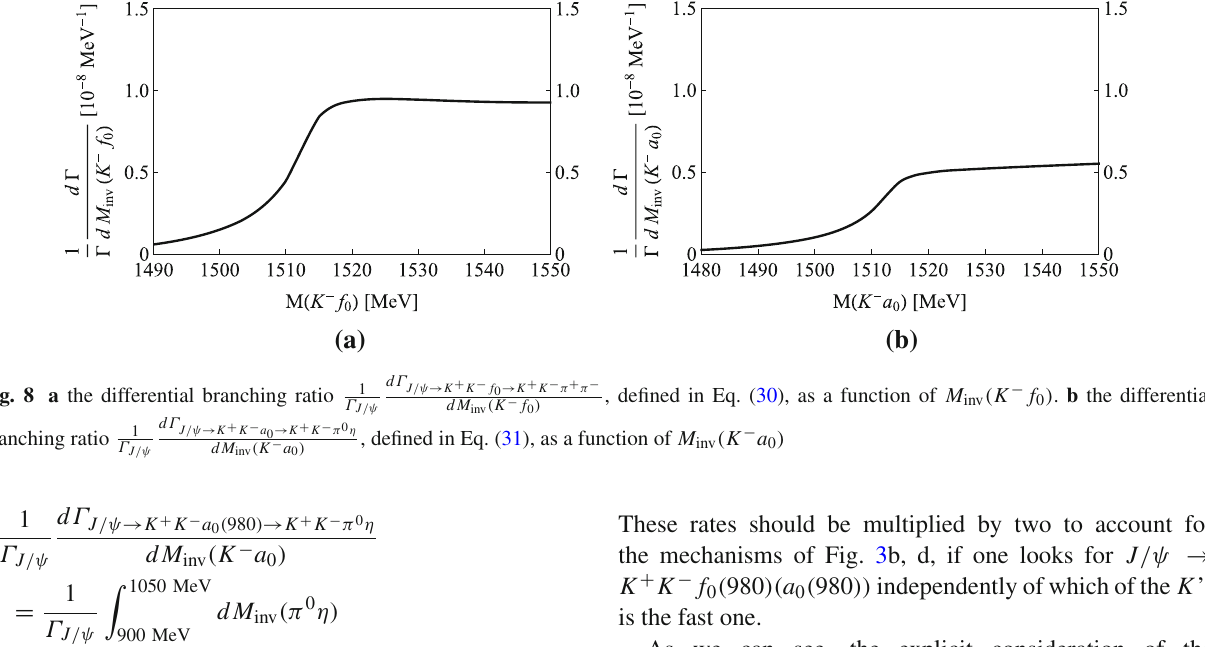
(b) d 2 Γ J /ψ → K + K − a + K − π 0 η 0 → K as a function of M inv (π 0 η) . The red, dM inv ( K − f 0 ) dM inv (π 0 η) J /ψ